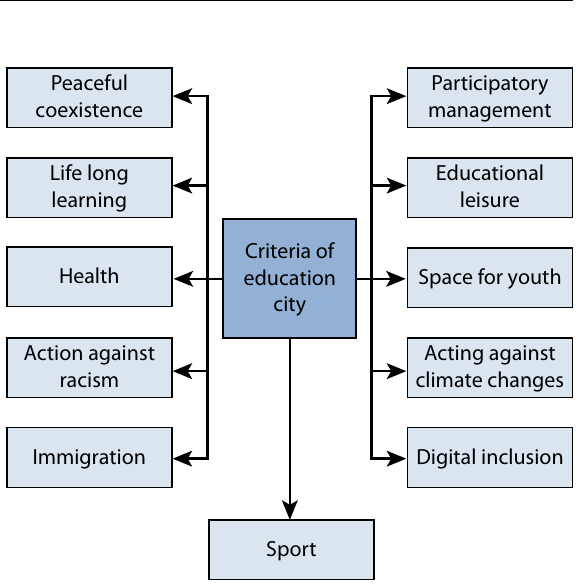
fig. 5. Global criteria of educating